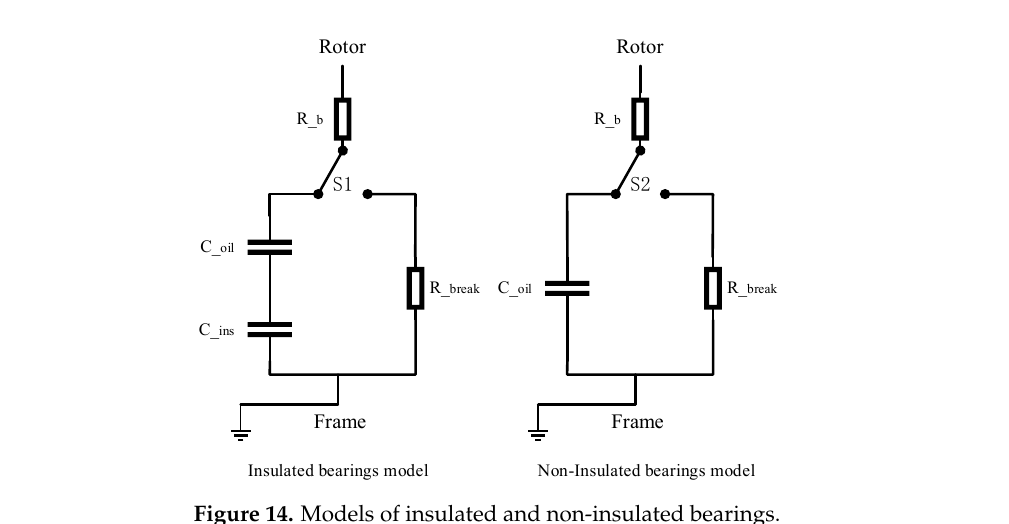
Figure 14. Models of insulated and non-insulated bearings.